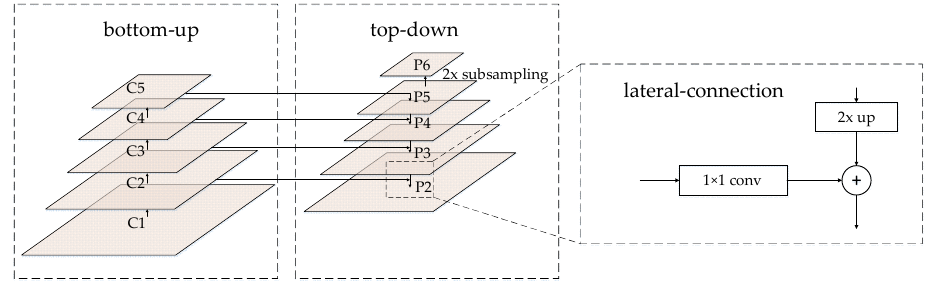
Figure 2. Architecture of the proposed region proposal network based on a feature pyramid network (FPN-RPN).